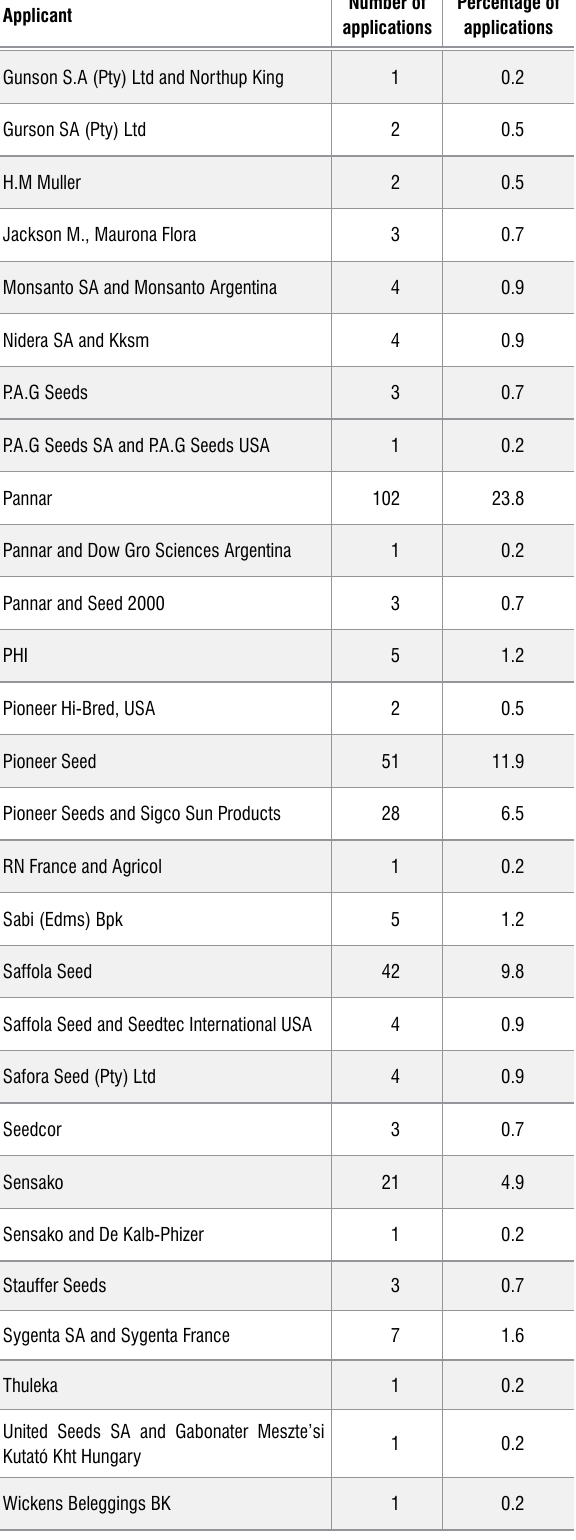
Figure 5 presents the changing composition of applicants of sunflower varietal inclusion on the national variety list. The majority of the varietal inclusion applications for sunflower varieties were filed by local private companies like Pannar, Pioneer, Sensako, Cargill, Carnia, Agroseed and